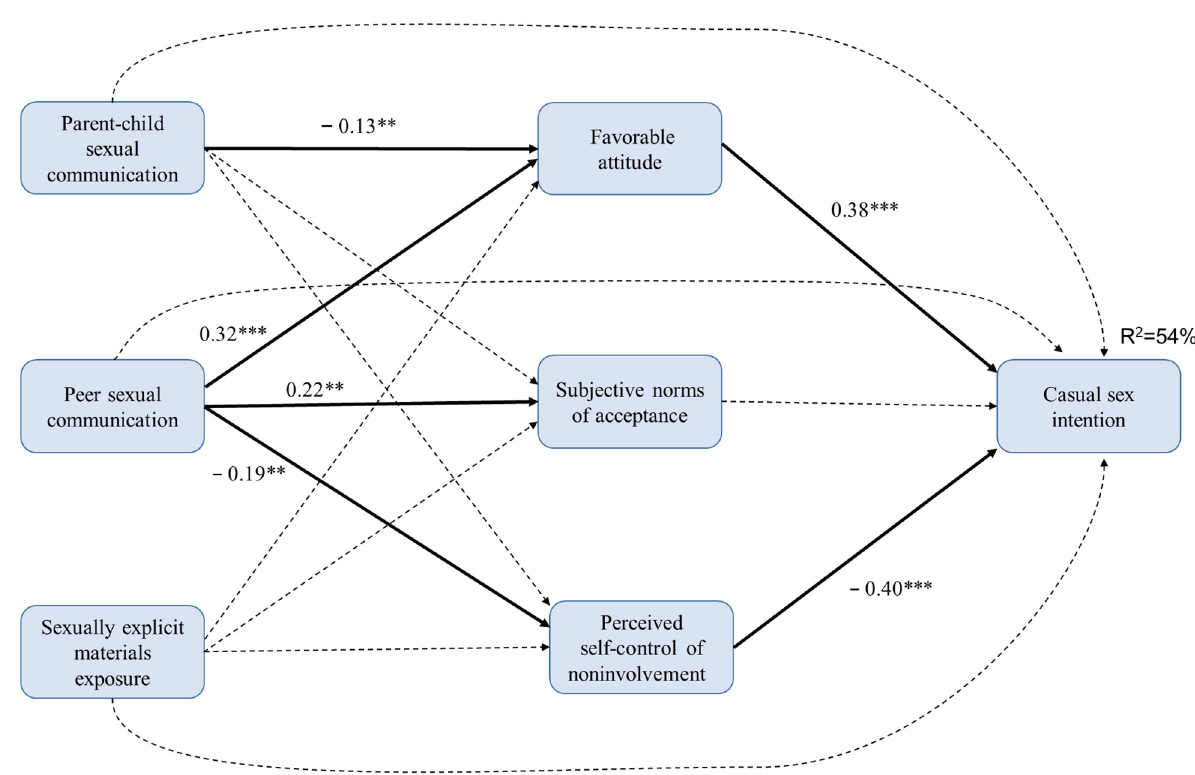
Figure 2. The standard coefficient of men. *** p < 0.001; ** p < 0.01; * p < 0.05. Solid lines denote significant paths and dotted lines denote non-significant paths.